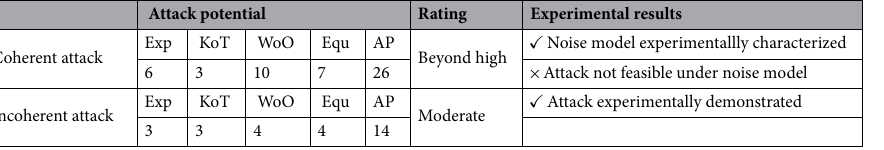
Table 2. Summary of the analysis on the two attacks to the homodyne detection. We have reported the values for each factor of the Attack Potential, namely: Exp. stands for Expertise, KoT for Knowledge of the TOE, WoO for Window of Opportunity and Equ for Equipment. The factors chosen for the analysis are from Common Criteria 25 .